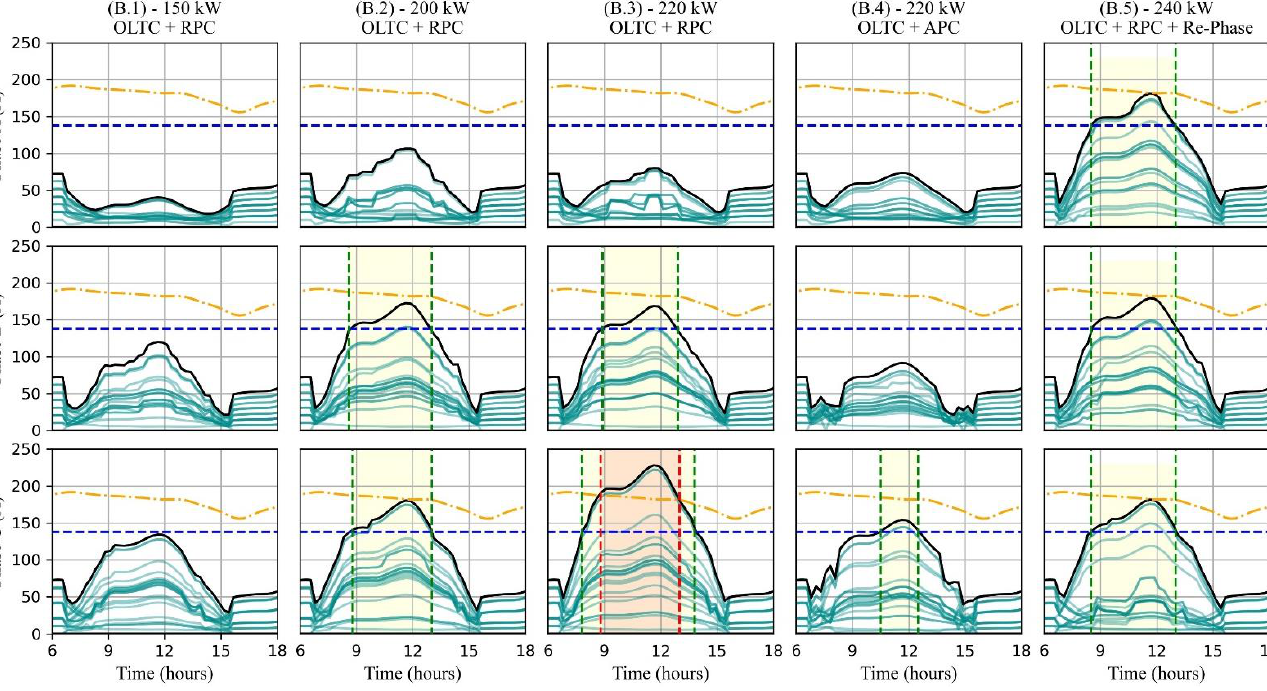
Figure 10. Time-series variation of nodal voltages under different scenarios during PV generation. Figure 11 depicts the variations in branch currents that correspond to the previously described test scenarios under test case B in Table 1. In subplots in Figure 11, the blue dashed line indicates the SLR, whereas the orange dashed-dotted line represents 75% of the calculated DLR. Further to that, the maximum values in currents are shown in black solid lines.